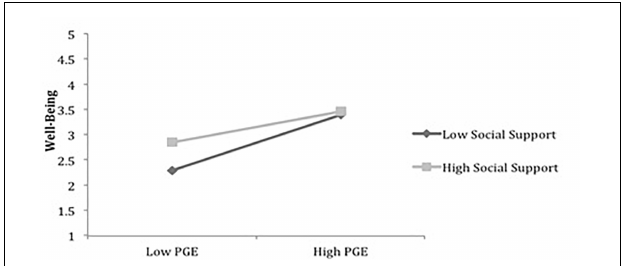
FIGURE 4 | The moderating effect of social support on PGE–Well-being relationship (total sample).